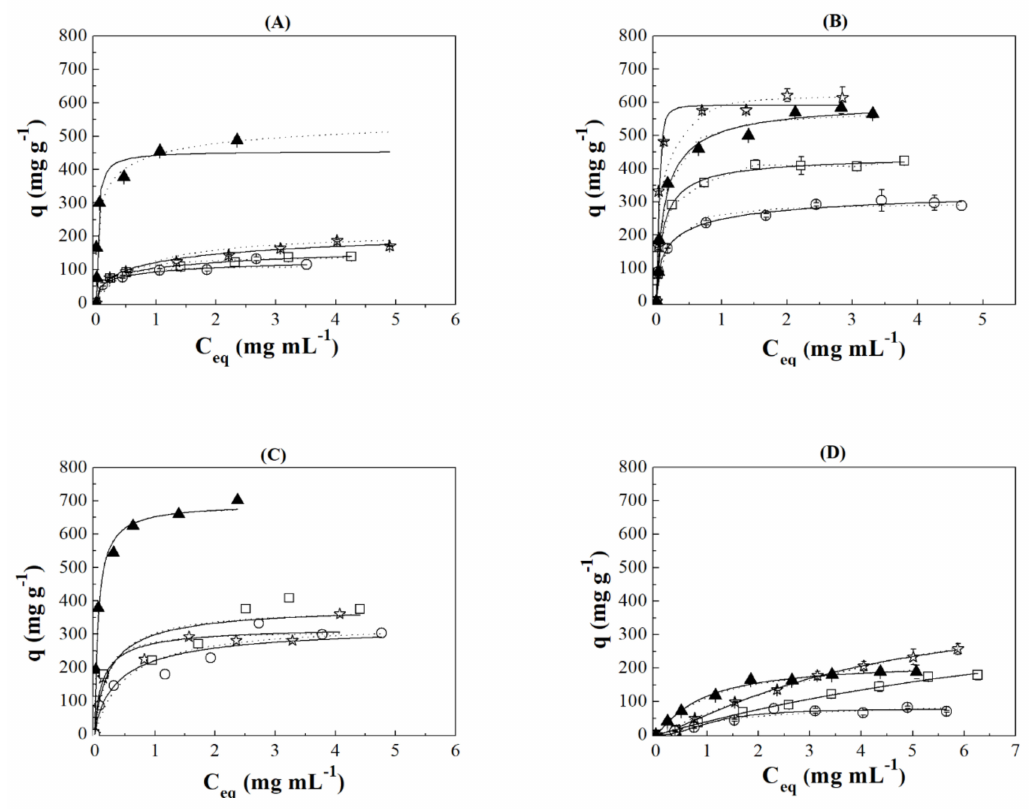
Figure 4. Adsorption isotherm of IgG ( A , C ) and HSA (B,D) in Si ( (cid:78) ), SiZr20 (*), SiZr10 ( (cid:3) ) and SiZr5 ( buffer ( A , B ) at pH 4,8 and phosphate ( C , D ) at pH 7.0. : the error of each